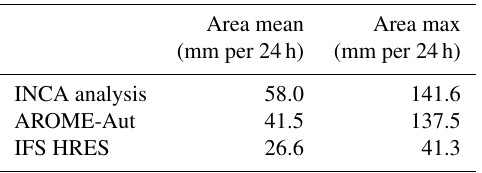
Table 6. 24h accumulated area mean and area max values for the region (longitude/latitude: 12.75–13.5/47.65–48.45) for INCA, AROME-aut and IFS-HRES.